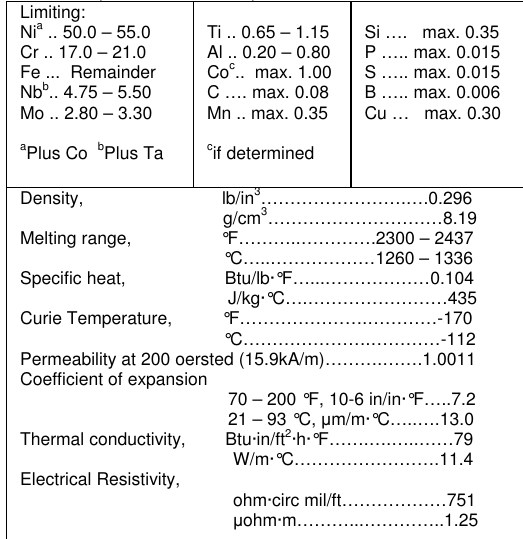
Fig 3. Frequency chart and value comparison table The continuation of modeling was directed to possible blades’ defects simulation [7]. Damaged side and upper edges for 5, 10, 15 millimeters and 5, 15, 30 millimeters accordingly, as also dents in frame were filled up with alternate material alloy - Inconel Alloy 718 [2]. Main differences between initial and welded alloys are focused on module of elasticity and thermal conductivity disparities are shown in the table [5–6].